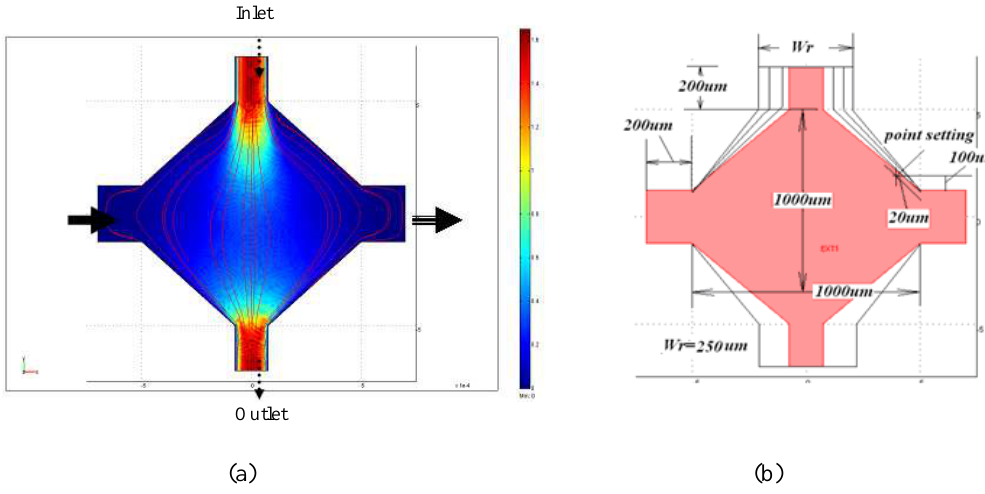
Figure 3 : (a) Flow behavior in the M-Zone predicted through FEM simulation (b) Geometry of the M-Zone, where W is the width of the rinsing channel. r